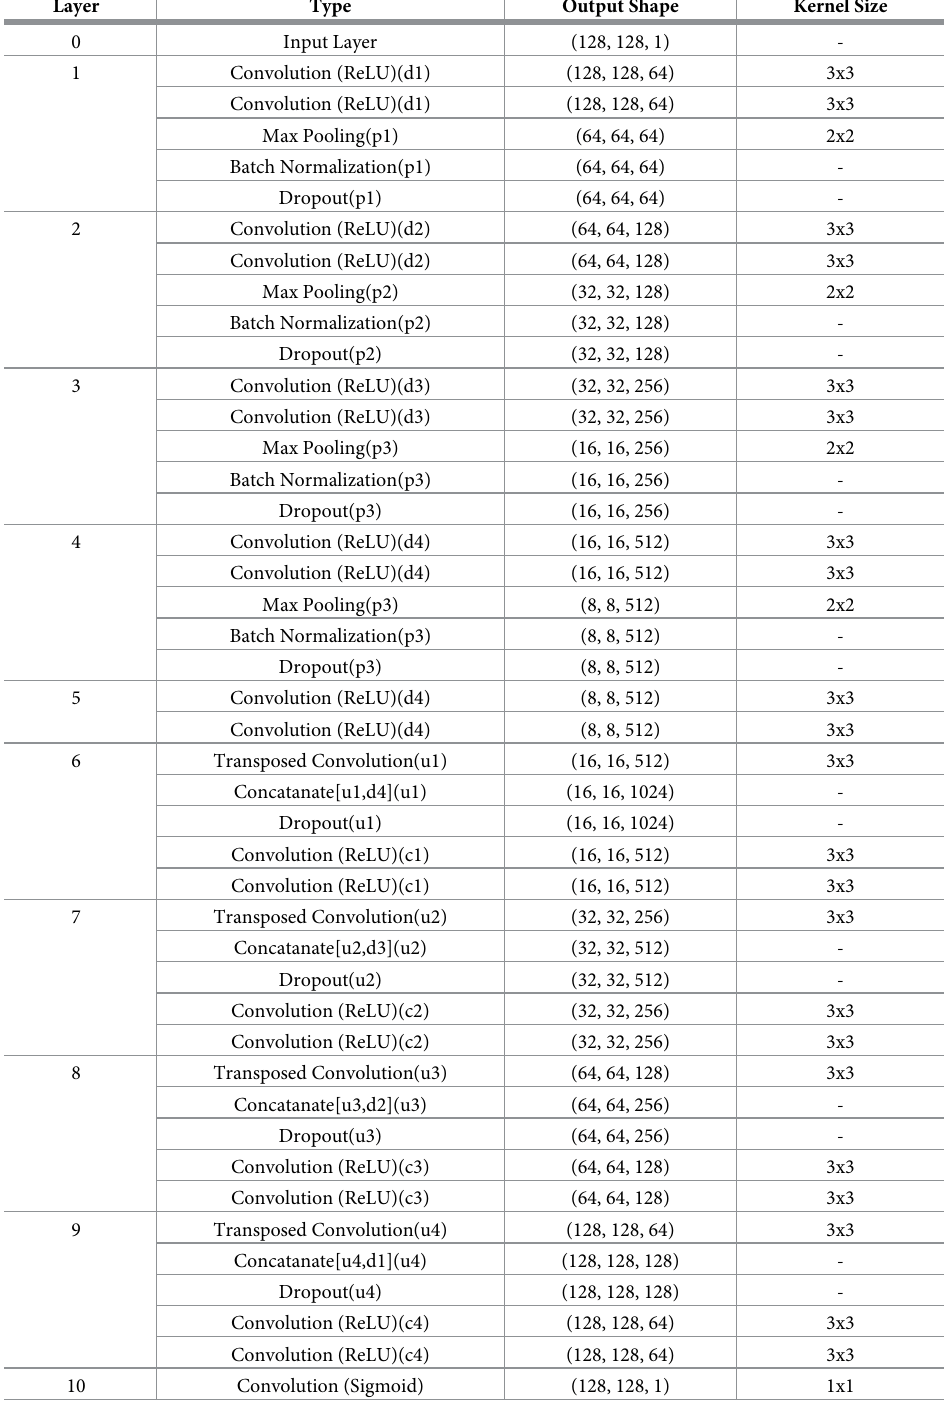
Table 3. Infection segmentation model: